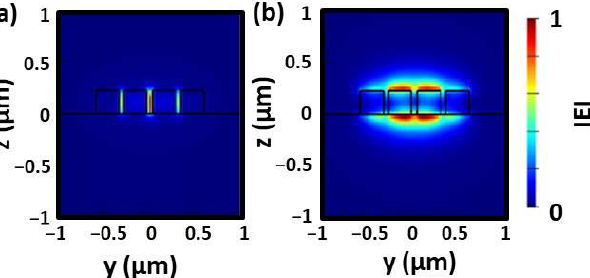
Figure 2. Optical intensity for Si MS-WG for ( a ) TE and ( b ) TM modes with SC = 3, W s = 60 nm, W t = 1100 nm, and H =220 nm.